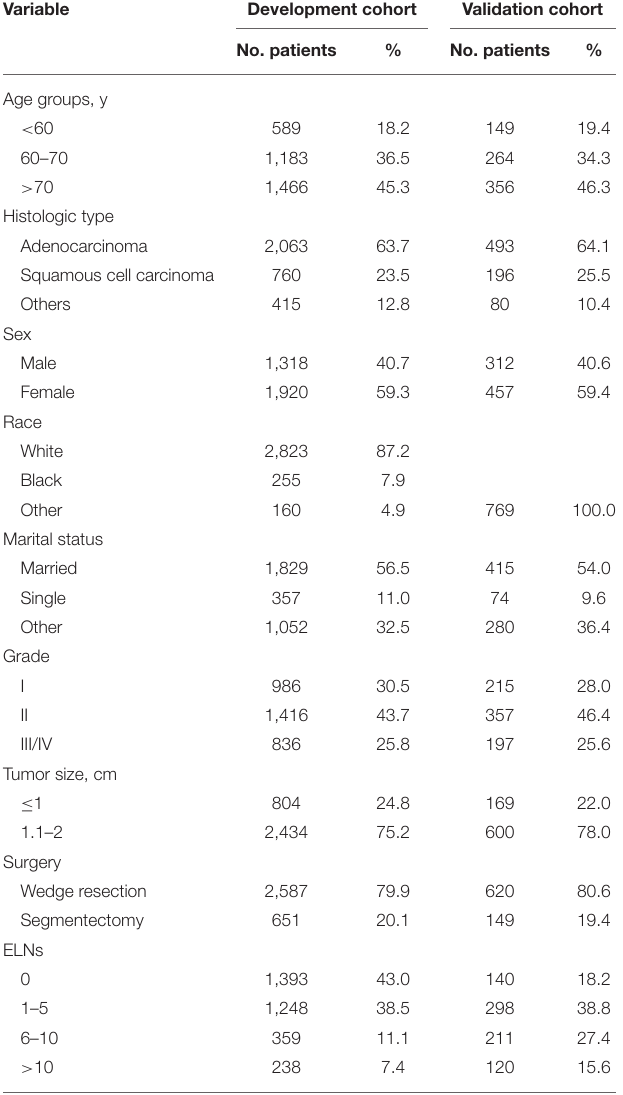
TABLE 1 | Patients